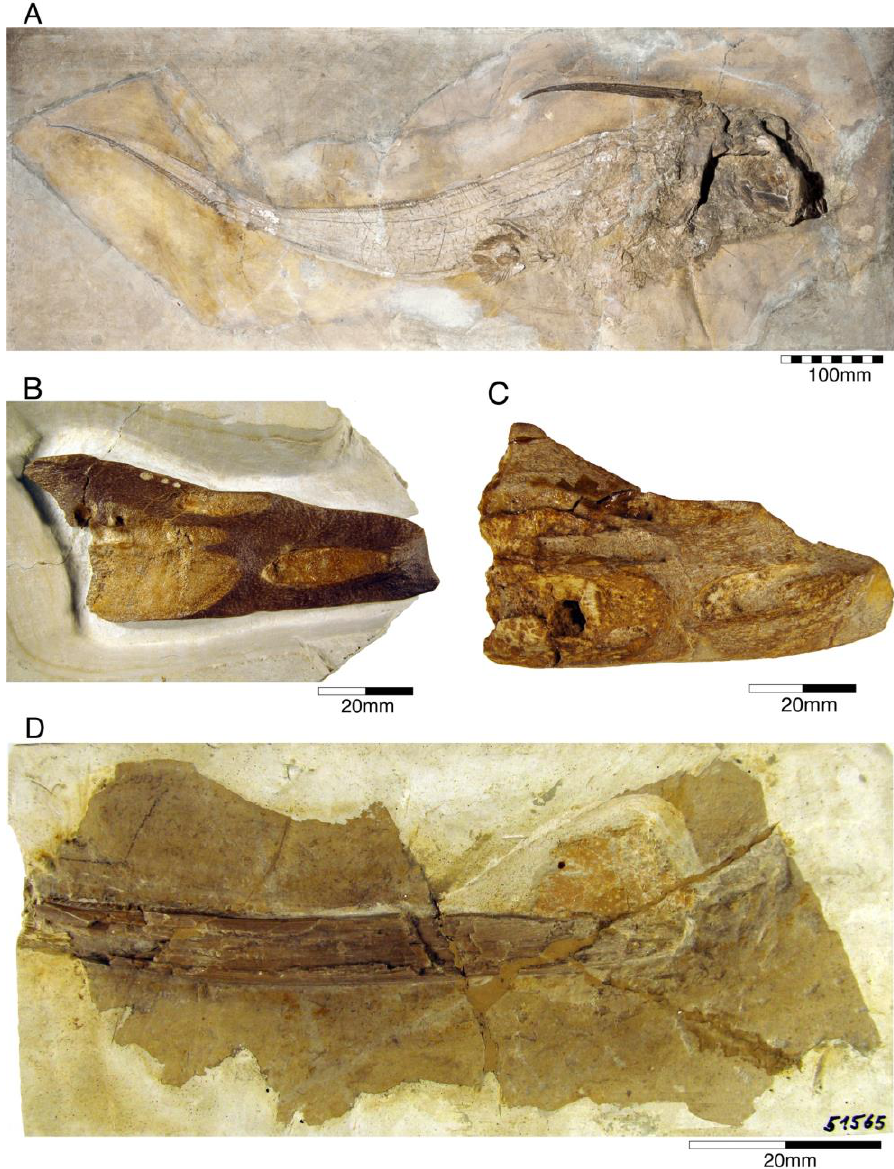
Figure 4. † Ischyodus egertoni (Buckland, 1936 [101]). ( A ) Holomorphic specimen (SNSB-BSPG 1954 I 366) from the early Tithonian Altmühltal Formation of Eichstätt, labelled as † I. quenstedti . This specimen was figured by Kriwet and Klug [19] (figure 675). ( B ) Right palatinal tooth plate (SMNS 96078/28) from the late Kimmeridgian Nusplingen Plattenkalk of the quarry of the Gesellschaft für Naturkunde Württemberg), labelled as † I. quenstedti . ( C ) Right palatinal tooth plate (SMNS 51566) from the upper Kimmeridgian of Nusplingen, labelled as † I. schuebleri . This specimen was collected by Fraas in 1855 and figured by Schweizer [66] (pl. 8, figures 5 and 6). ( D ) Isolated fin spine (SMNS 51565) from the upper Kimmeridgian of Nusplingen, labelled as † I. schuebleri . Among callorhynchids, † Ischyodus has the longest fossil record ranging from the Middle Jurassic (Bajocian) to the Neogene (Miocene-Pliocene). However, most